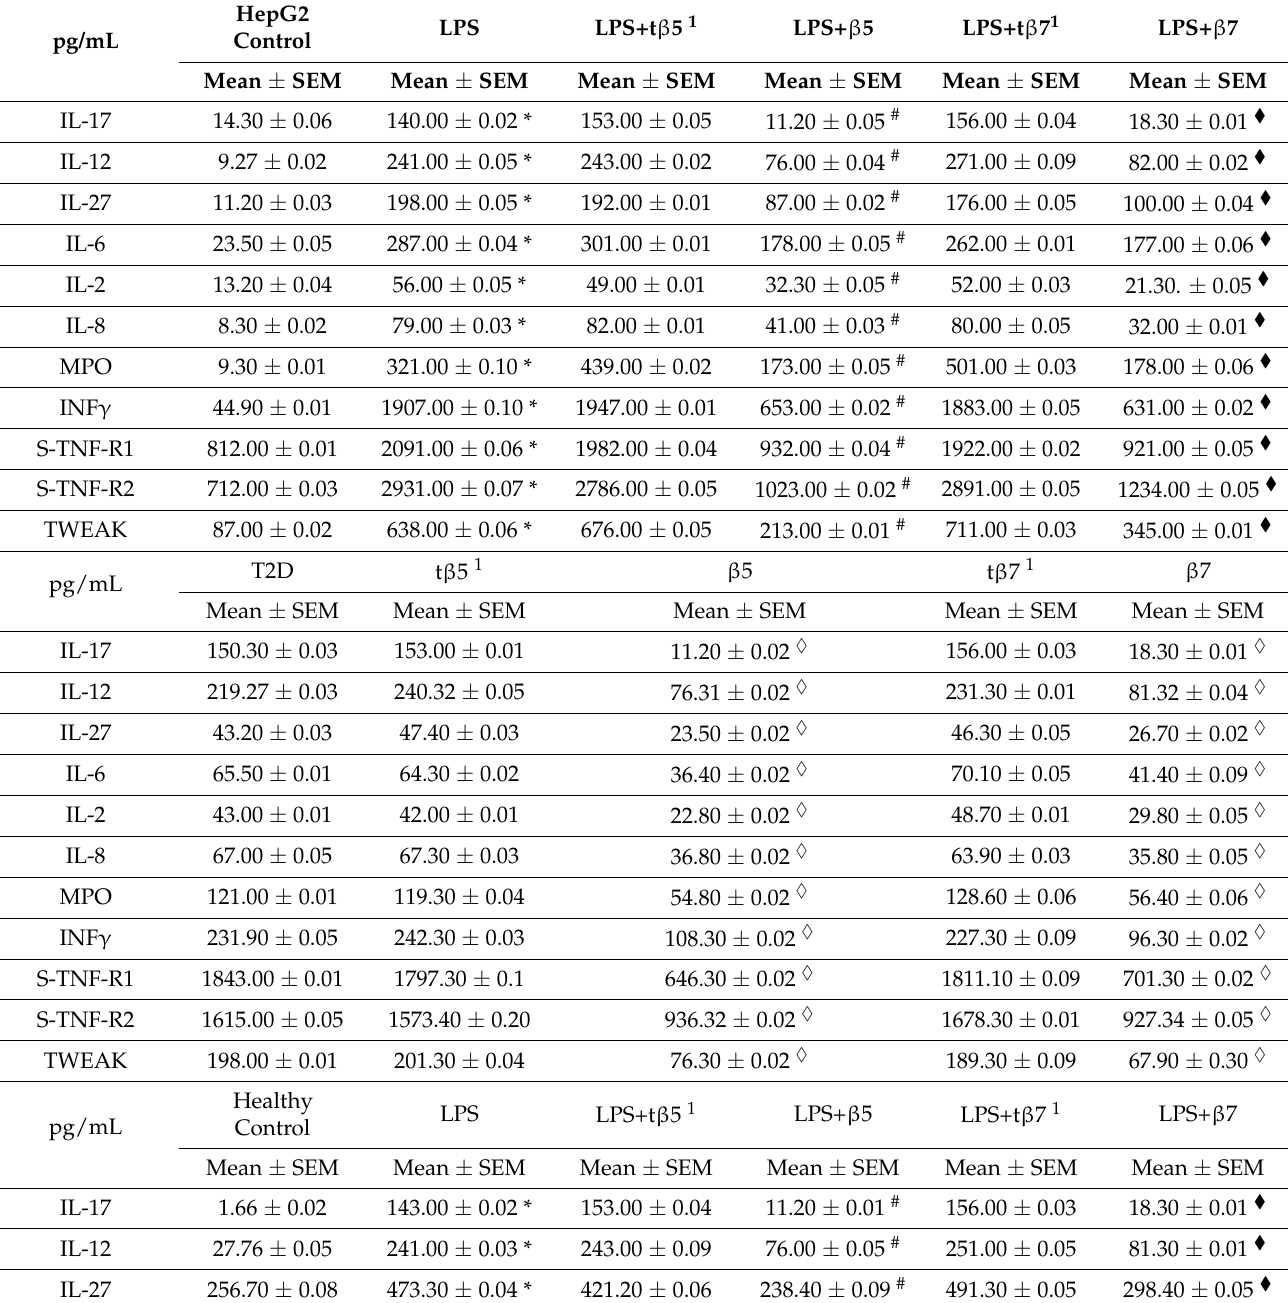
Table 1. Changes in protein levels of pro-inflammatory cytokines and other mediators. Pro-inflammatory cytokines and other mediators measured in HepG2, in T2D and in healthy control subjects’ cell culture, respectively. Numbers represent pg/mL of proteins measured by ELISA. Positive values mean gene up-regulation. HepG2 cell culture: * p < 0.05 vs. control, # p < 0.05 vs. LPS, (cid:7) p <0.05 vs. LPS; No differences for LPS vs. LPS+t β 5 or t β 7. T2D cell culture: ♦ p < 0.05 vs. T2D; No differences for T2D